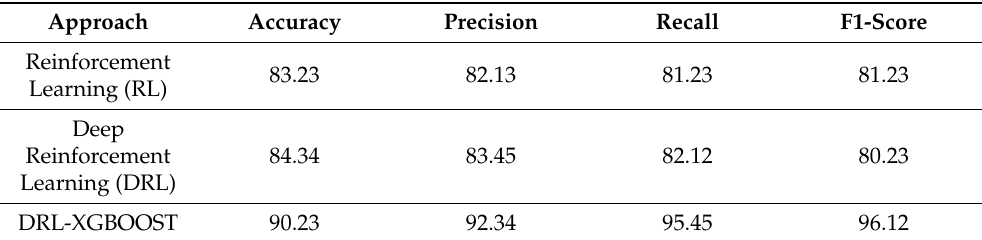
Table 3. Performance analysis with different